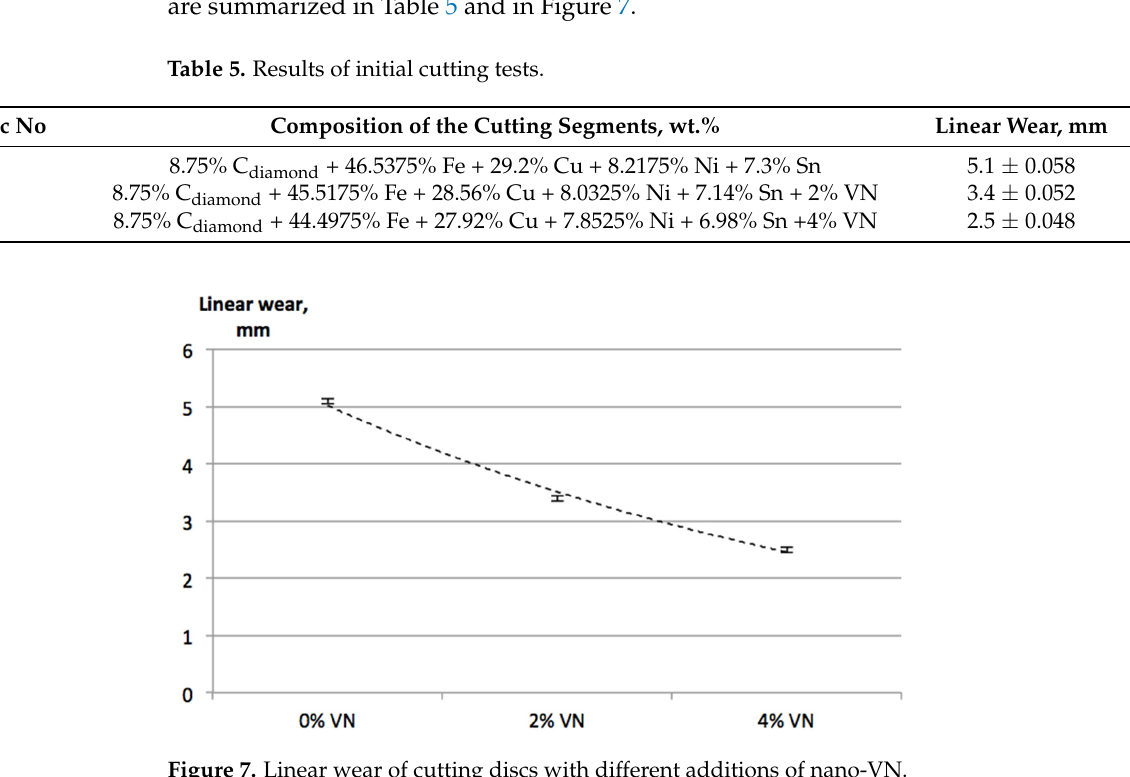
Figure 7. Linear wear of cutting discs with different additions of nano-VN.